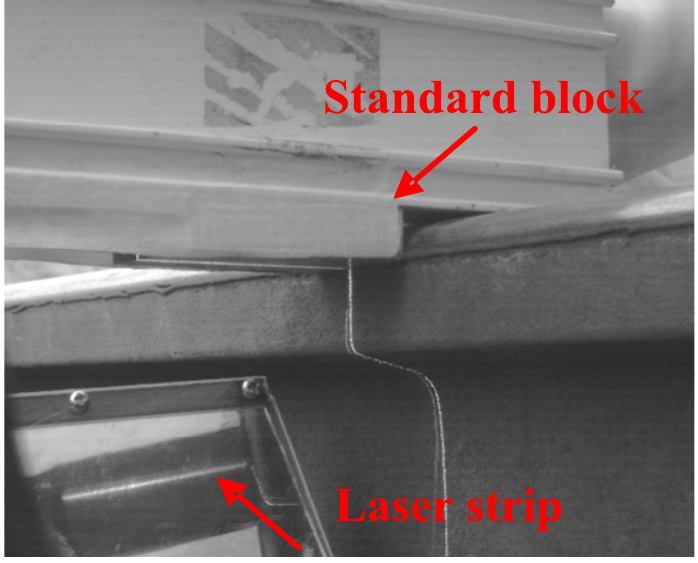
Figure 11. Calibration image of flange thickness in the